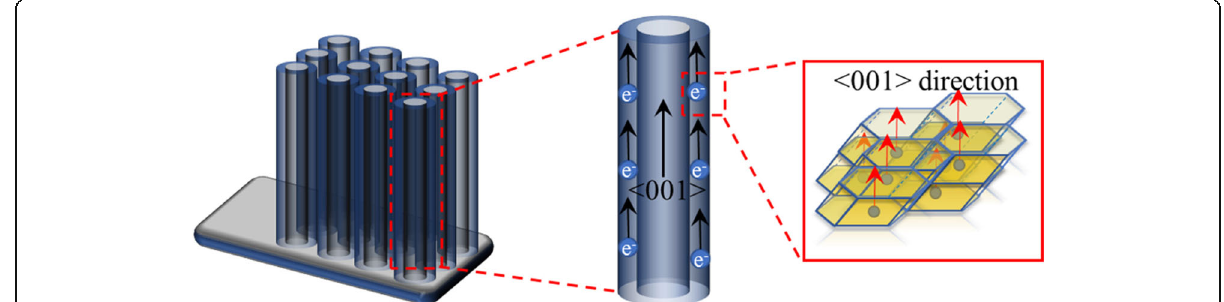
Fig. 6 Schematic diagrams showing the efficient transfer of carrier along <001> direction within H@TNAs-1